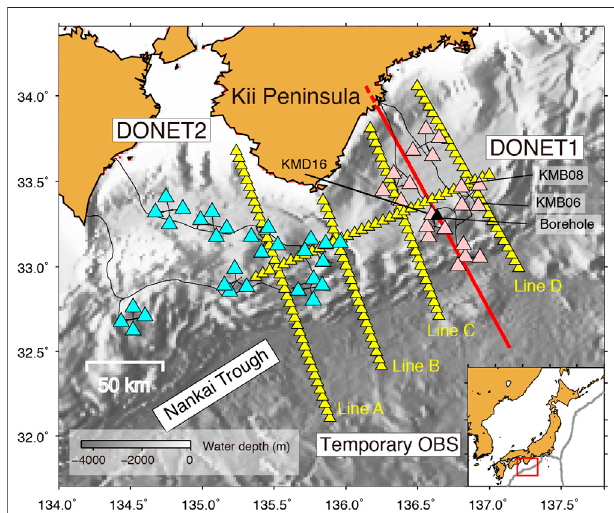
FIGURE 1 | Map showing the stations used in this study. Yellow, pink, andlight-bluetrianglesrepresenttemporary,DONET1,andDONET2stations, respectively. The black triangle indicates the borehole location. The red line show the location of Vp structure (Nakanishi et al., 2008) used in the numerical simulation. The dashed red line represents the region where the one-dimensional pro fi le at the northern edge of the Vp structure is